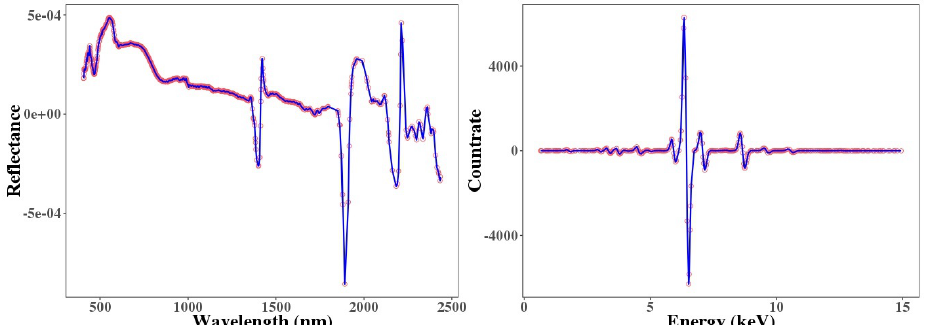
Figure 7. Feature selection by genetic algorithm (GA) from vis–NIR and XRF spectra (blue lines are the first derivative spectra, and the red dots are the selected